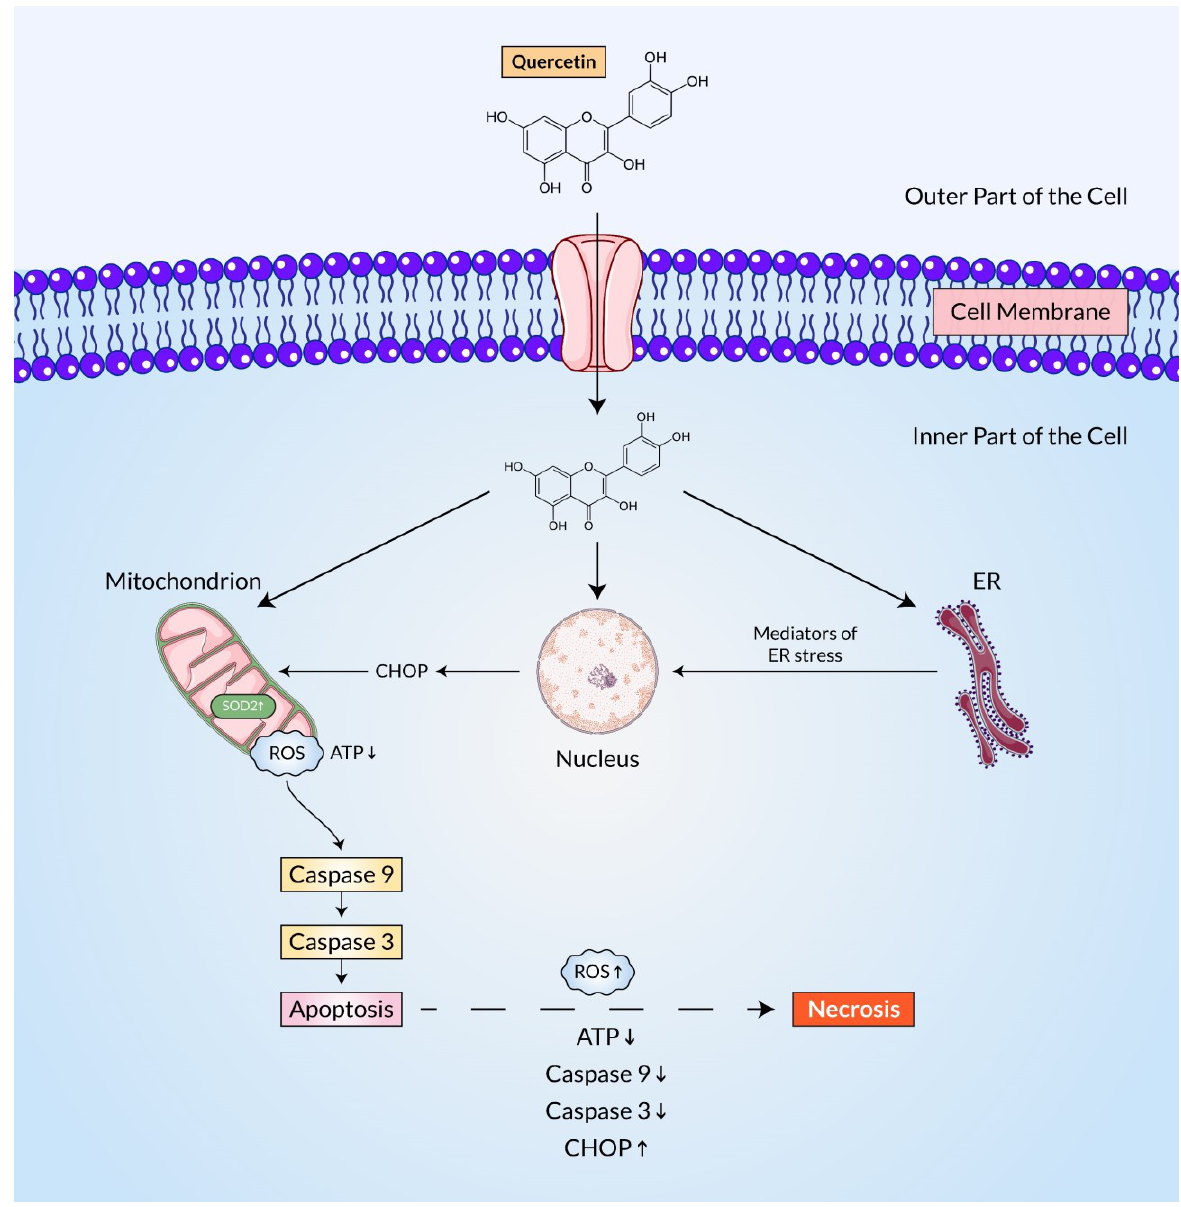
Figure 8. Mechanistic illustration of the function of quercetin in cancers cells by regulating ROS and p53-related pathways.